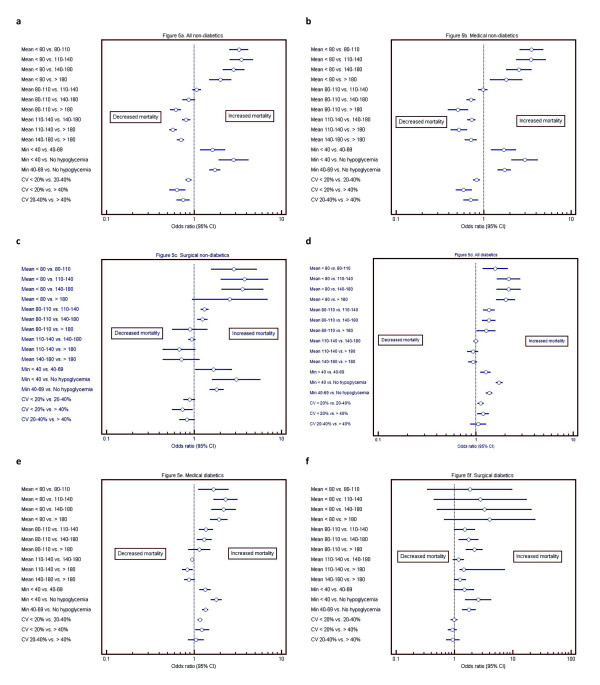
Forest plots of bands of the independent association of mean BG,
hypoglycemia, and coefficient of variation to mortality, for diabetes and
nondiabetes patients. This figure illustrates the independent
association of mean BG, hypoglycemia, and coefficient of variation to
mortality, for diabetes and nondiabetes patients, including stratification
based on medical versus surgical status. Pair-wise comparisons of odds ratio
(95% CI) for each domain of glycemic control are presented.